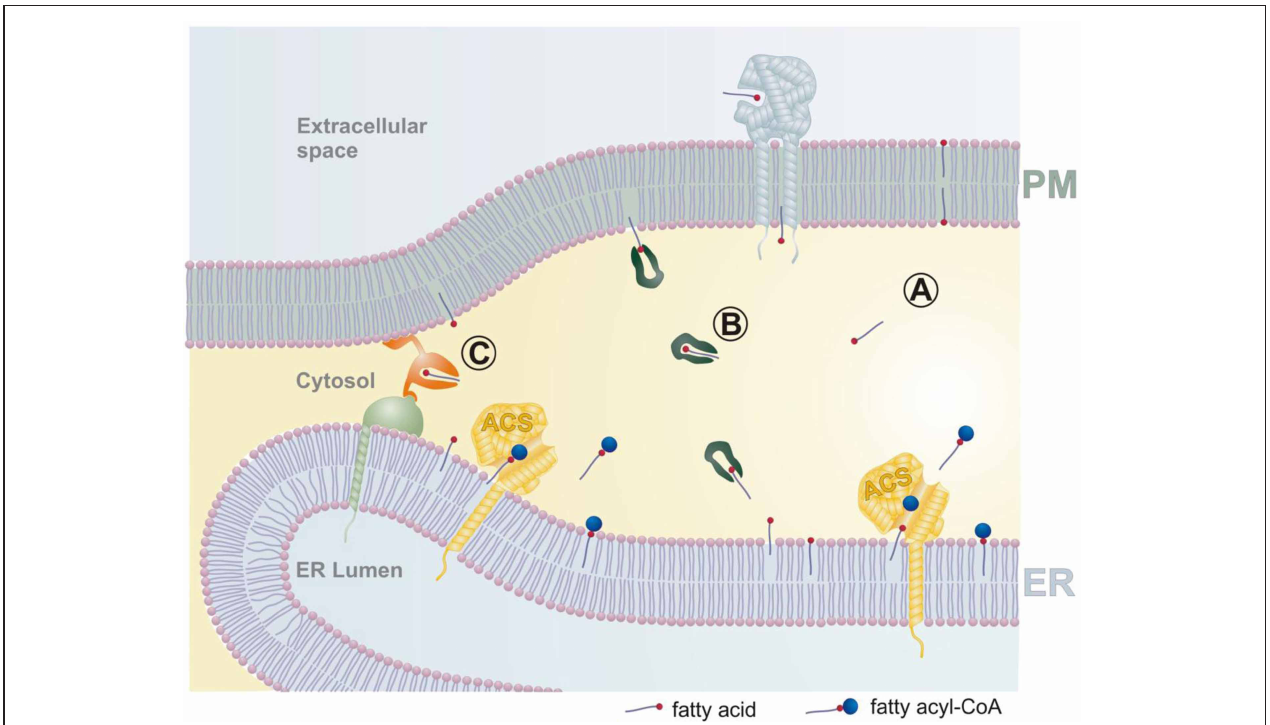
FIGURE 1 | Membrane junctions enable the metabolic trapping of fatty acids by intracellular acyl-CoA synthetases. Fatty acids from the extracellular space become integrated into the plasma membrane, which is likely facilitated by plasma membrane associated fatty acid binding proteins (light blue). Transport of fatty acids between the plasma membrane and the endoplasmic reticulum (and other intracellular organelles) may be organized by three different pathways. (A) Fatty acids diffuse spontaneously across the narrow membrane junction. (B) Cytosolic fatty acid binding proteins (dark green) may act as lipid chaperones to